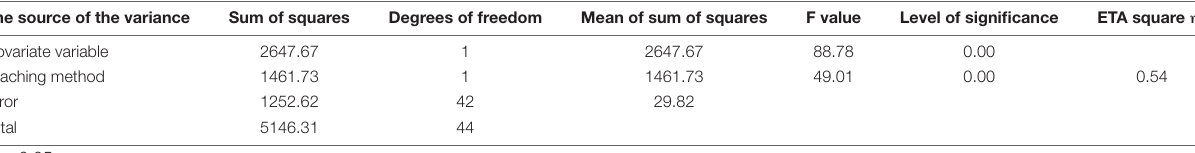
TABLE 5 | Scores of the six students participating in the interview on the proportional reasoning test.